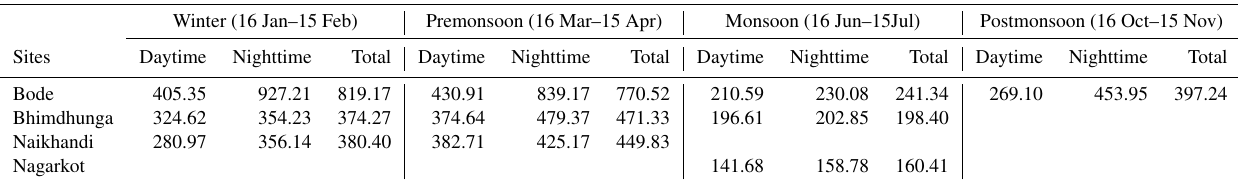
Table 4. Average CO mixing ratio (ppb) at different times of the day (daytime – 12:00–16:00LT, and nighttime – 23:00–03:00LT) and the monthly average (total) at four sites in the Kathmandu